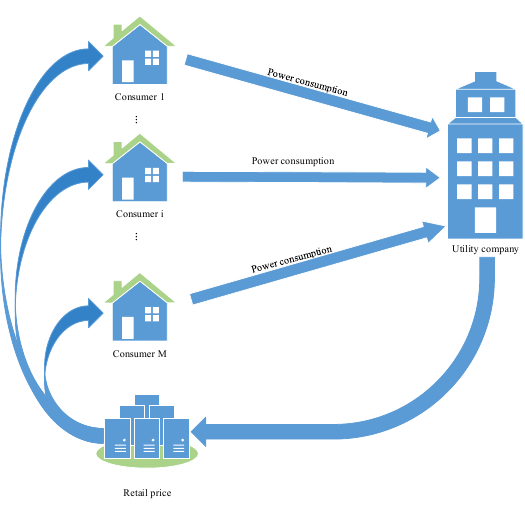
Figure 1. Demand-side management system.